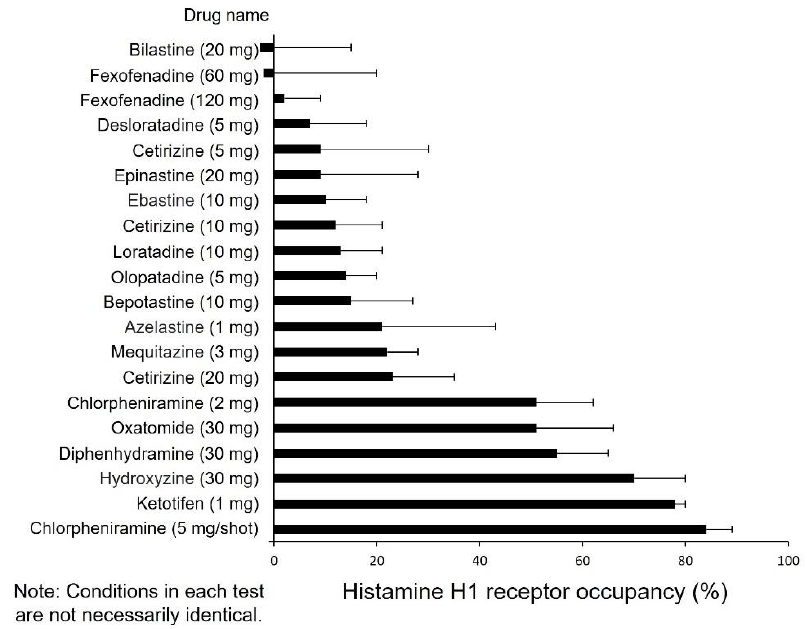
Figure 4. H1 receptor occupancy and sedation of antihistamines in the brain.